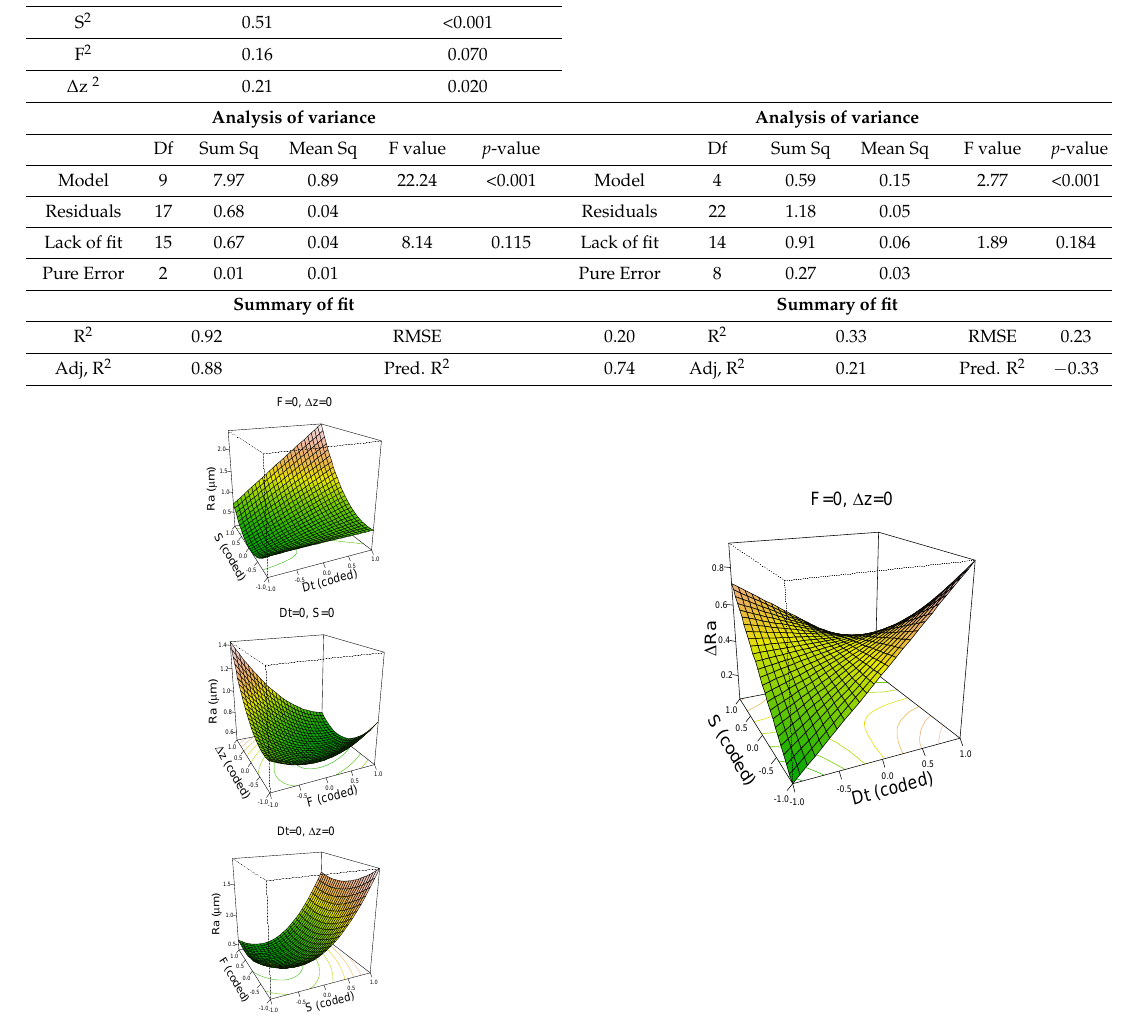
Table 4. Surface Roughness (Ra) model